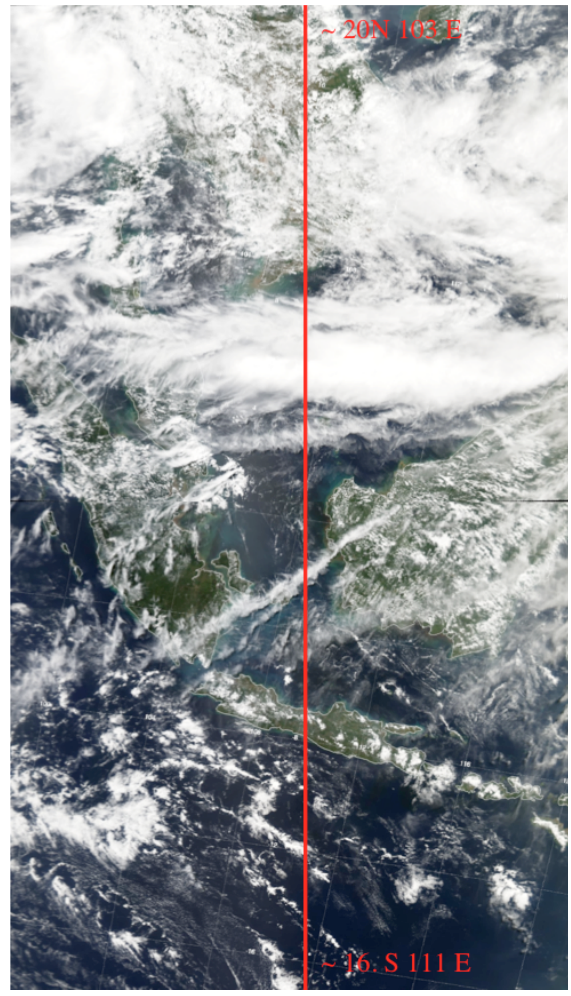
Fig. 2. An example of a visible image composite derived from the MODIS imager onboard the Aqua satellite during 22 July